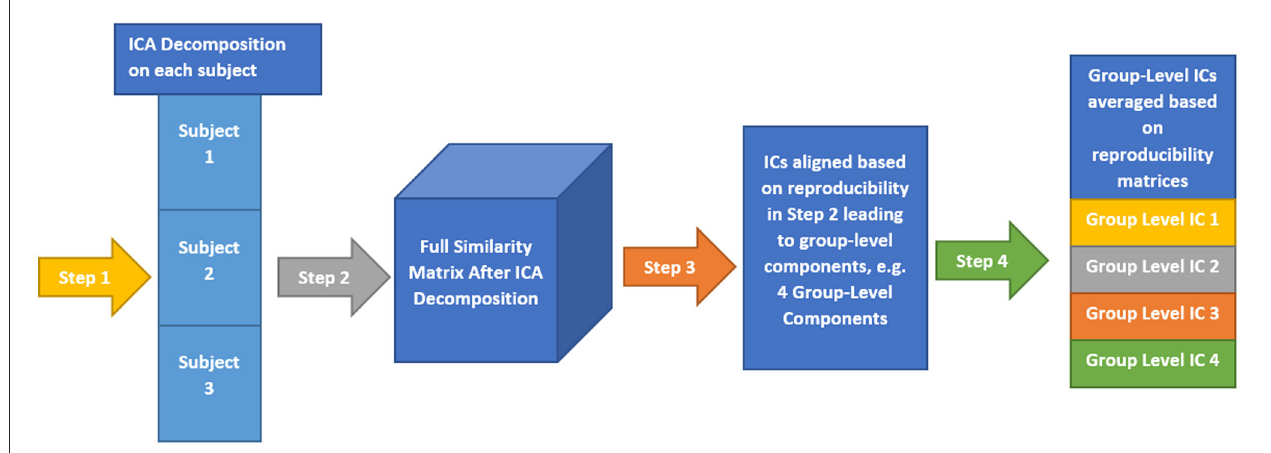
FIGURE 3 | This illustrates the implementation of gRAICAR algorithm using 3 subjects with 3 subject-level components each as an example. Step 1 involves multiple ICA realizations for each subject. Step 2 is used to create a full similarity matrix (FSM). In step 3, ICs are aligned based upon similarity metrics. In step 4, ICs are averaged based upon reproducibility